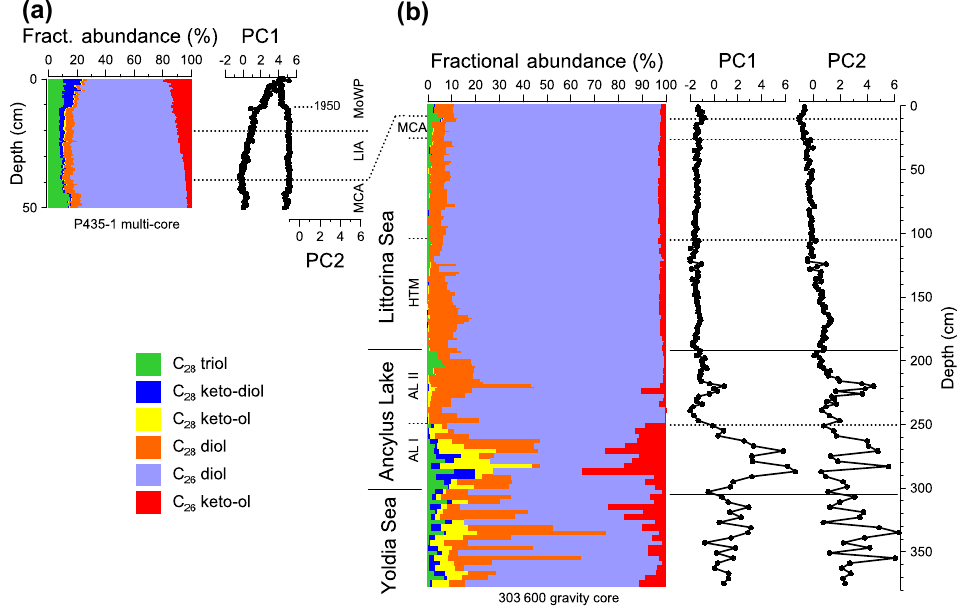
Figure 4. Distribution of HGs, displayed as fractional abundance (%) vs. depth (in cm) for (a) the MUC P435-1-4 core and (b) the GC 303600 core. Color key: light green – C 28 triol HG; blue – C 28 keto-diol HG; yellow – C 28 diol HG; orange – C 28 keto-ol HG; purple – C 26 diol HG; red – C 26 keto-ol HG. Each sample represents a sediment slice of 0.5cm in the case of the MUC and of 1 or 2cm in the case of the GC. The stratigraphy of the cores (see Fig. 3) is indicated. The scores on PC1 and PC2 derived from the principal component analysis of the HG distribution are plotted along the fractional abundance plots using the same scale for both